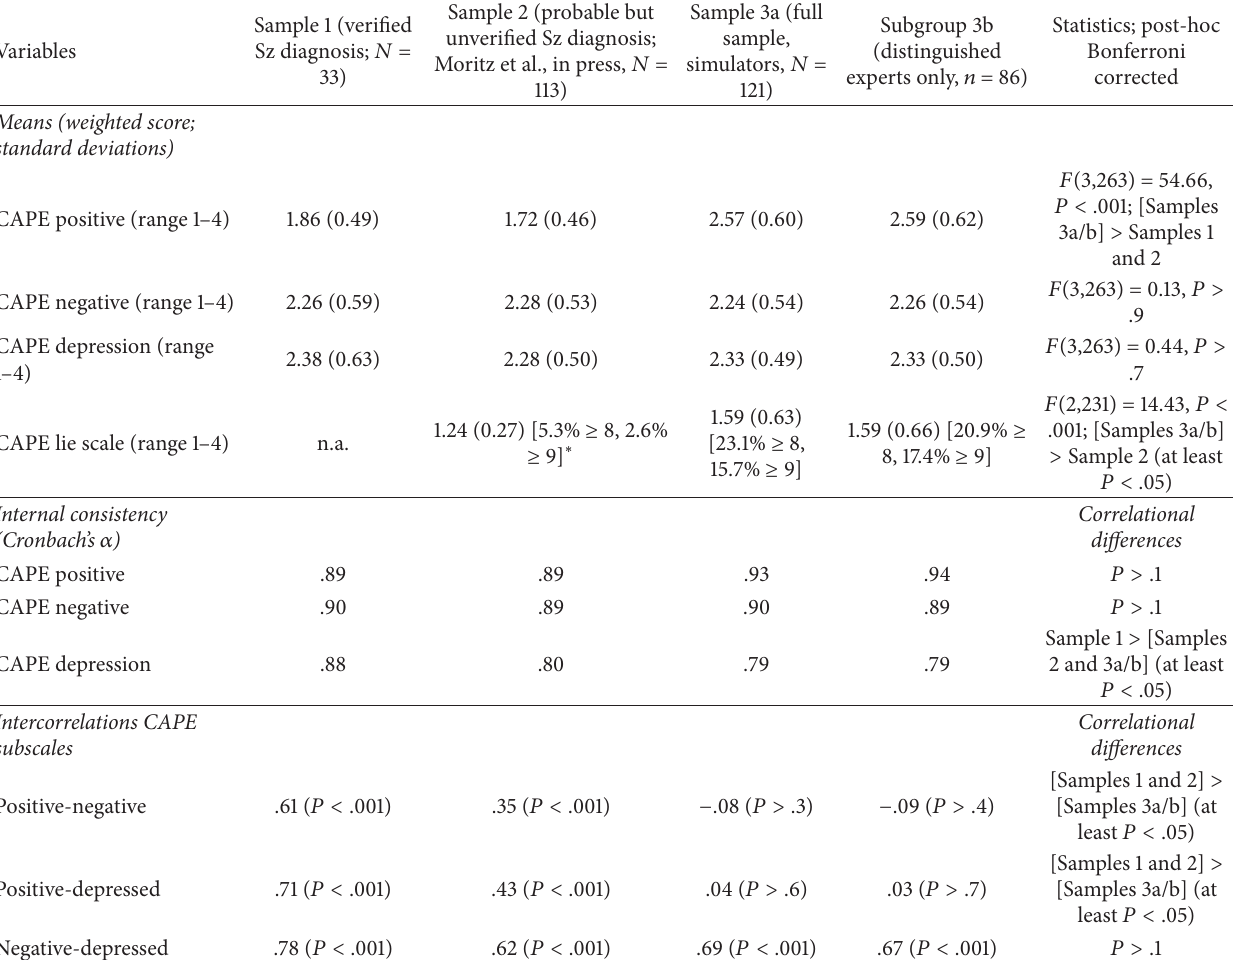
Table 1: Psychometric properties (in square brackets: results for patient groups [Samples 1 and 2] versus “simulators” [Samples 3a and 3b, see text for